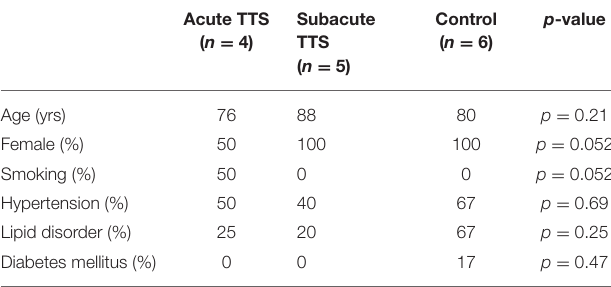
TABLE 1 | Baseline demographic and vascular risk